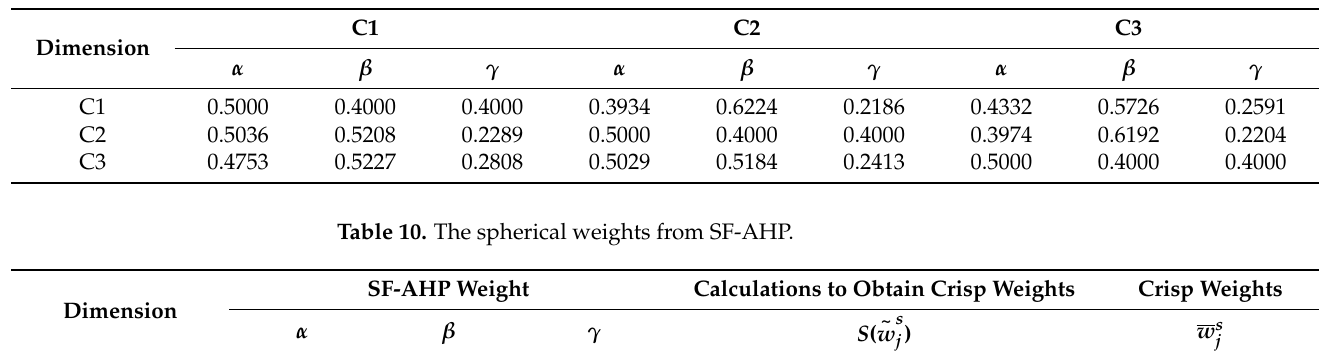
Table 9. The integrated spherical fuzzy comparison matrix.